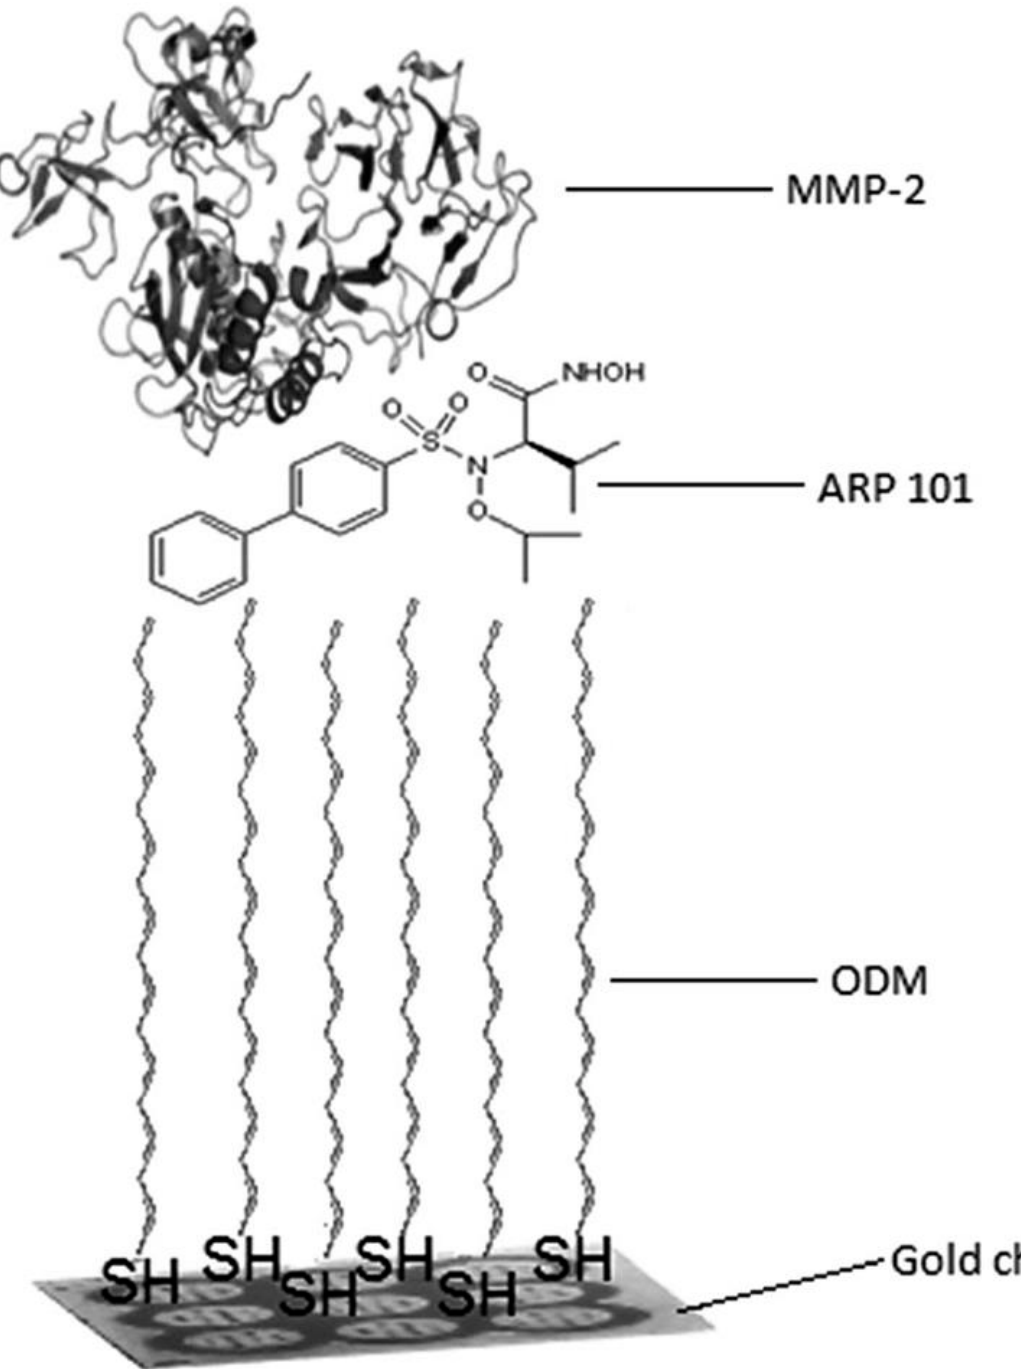
Figure 5. Example of receptor immobilization via hydrophobic interaction. Reproduced from [24] with permission of Royal Society of Chemistry. permission of Royal Society of